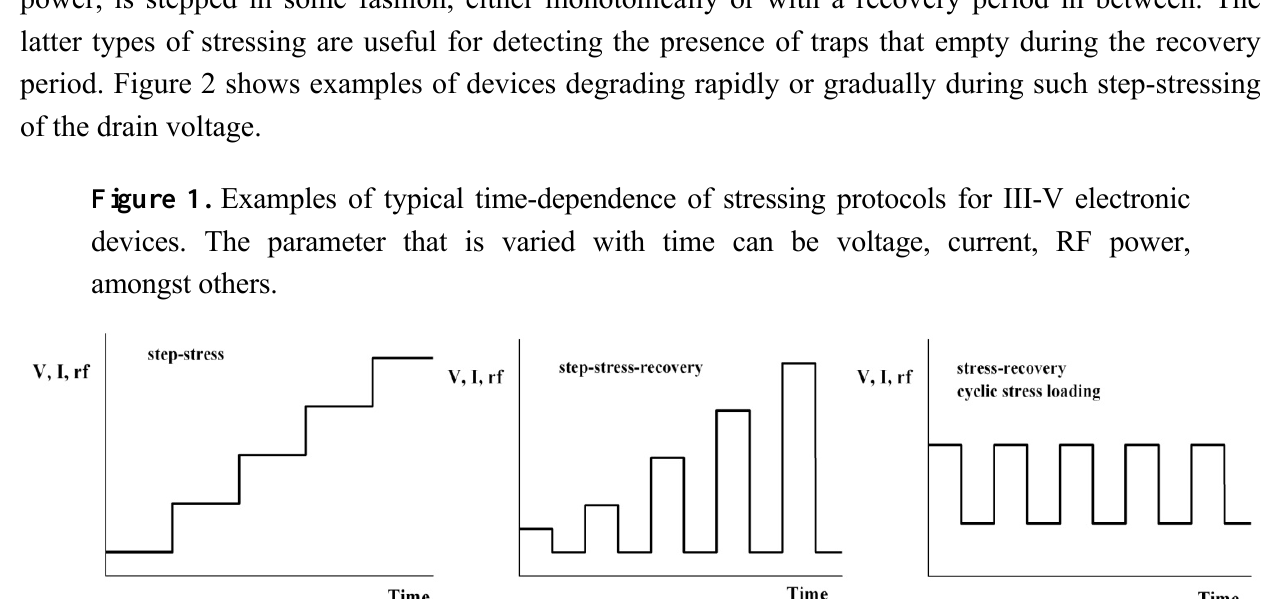
Figure 2. Examples of catastrophic ( a ) and gradual degradation ( b ) of GaN high